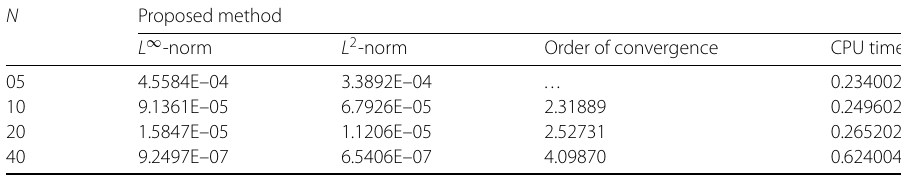
Table 4 Maximum absolute errors and Euclidean norm ( L 2 ) for Problem